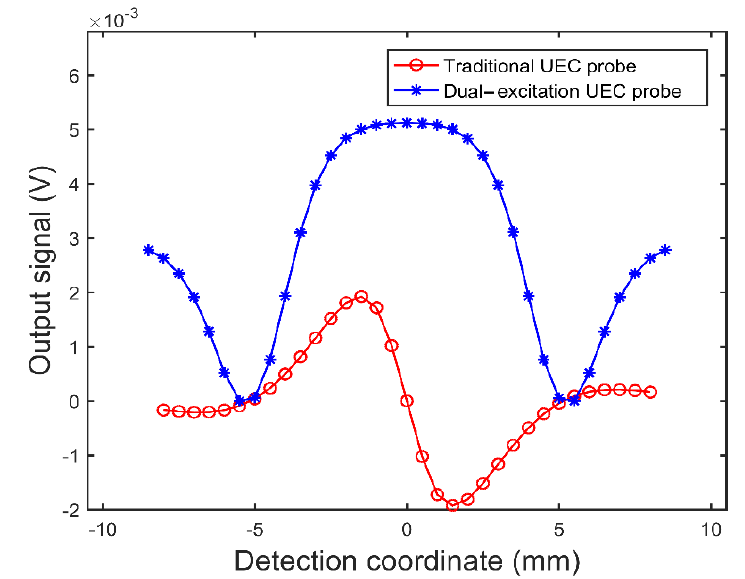
Figure 8. The crack defect signals of the two UEC probes.